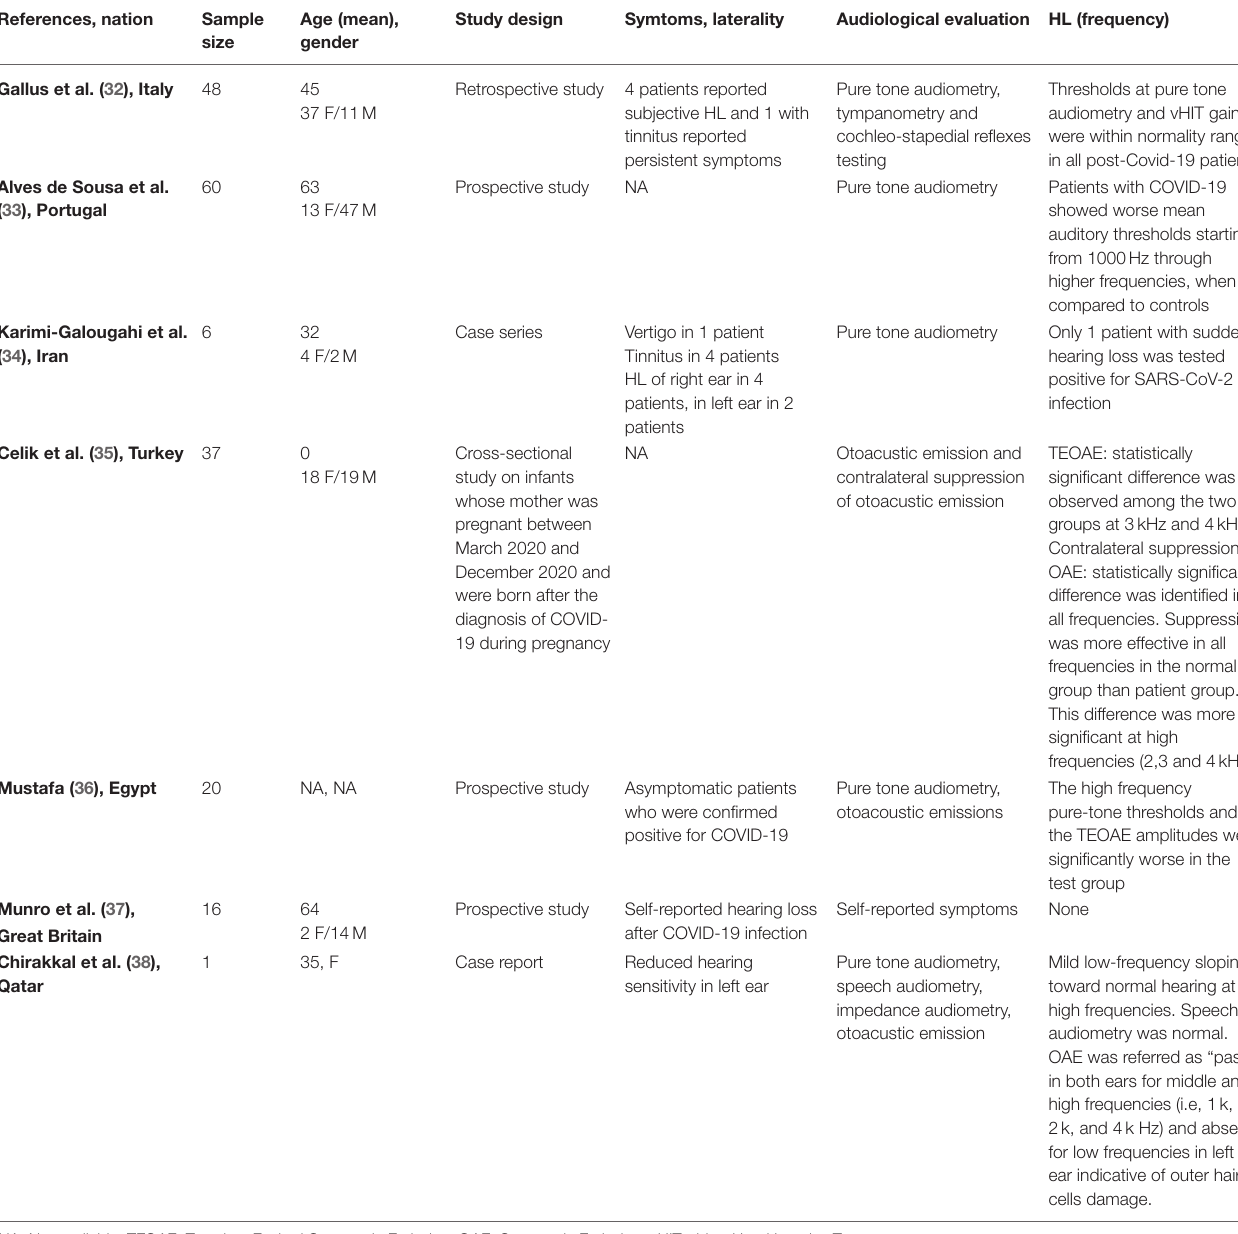
TABLE 3 | Characteristics of studies exploring hearing loss (HL) in patients with COVID-19 included in the systematic